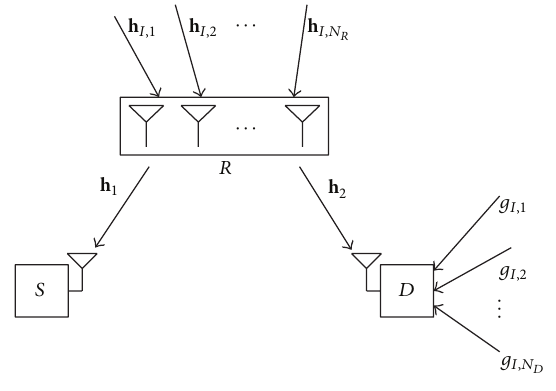
Figure 1: System